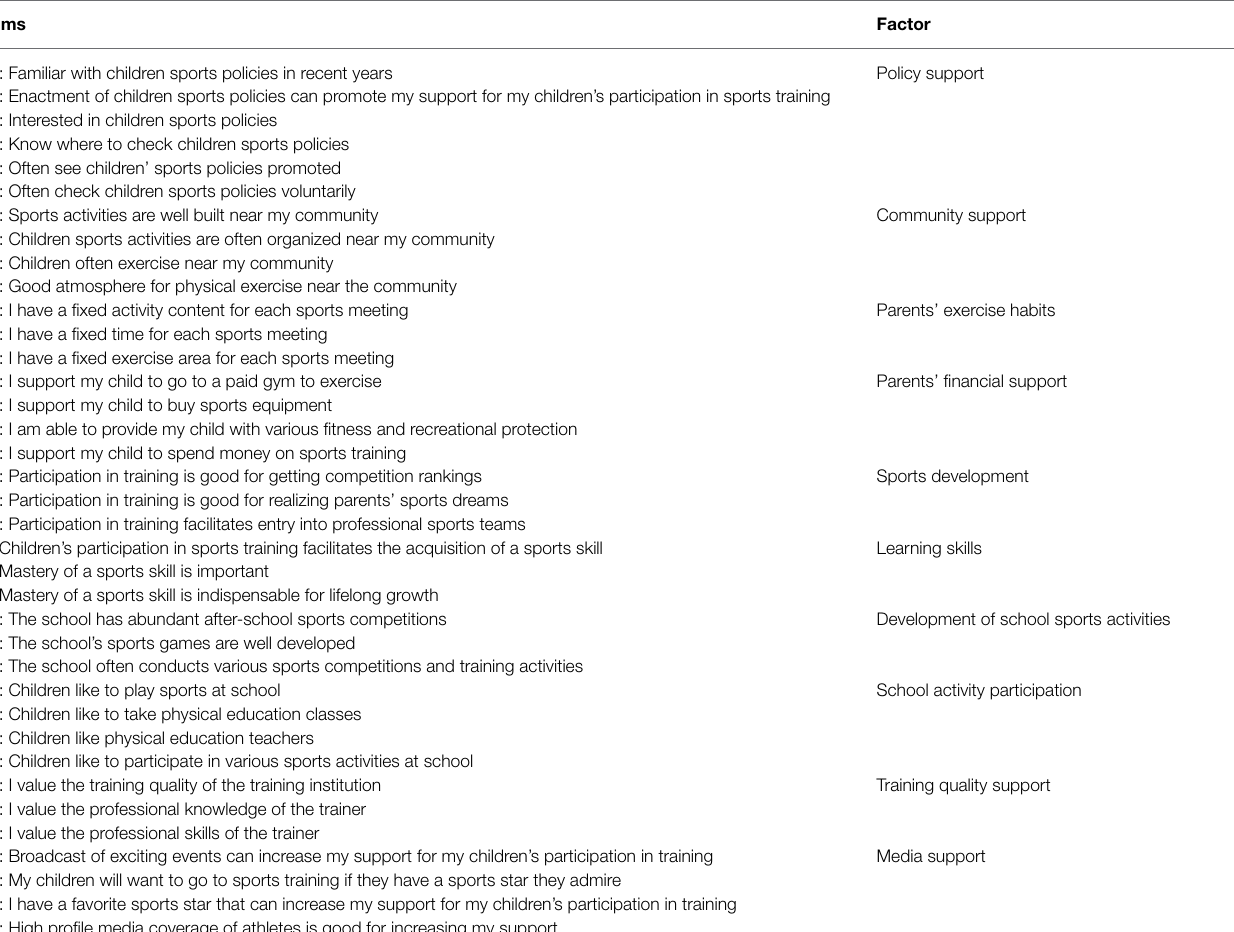
TABLE 4 | Items and dimensions of PSCSTS (translated from the Chinese